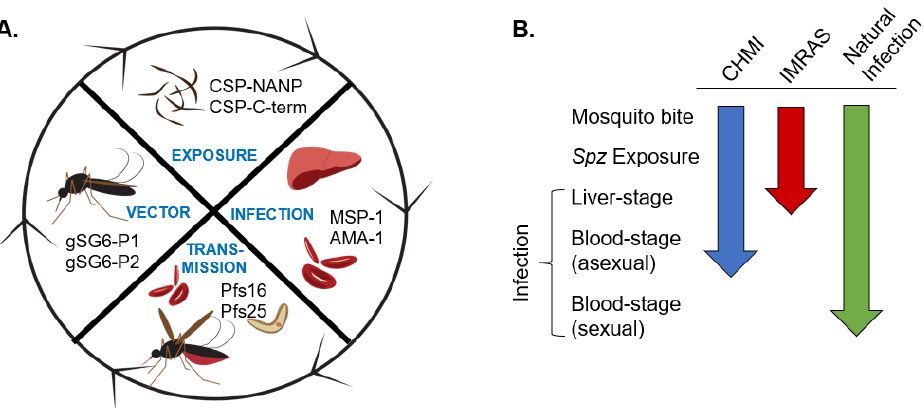
Figure 1. Antigen selection and malaria transmission cycle. ( A ) Antigens for vector, parasite exposure, infection, and transmission are shown along the malaria transmission cycle. ( B ) Different stages of exposure to the malaria transmission cycle for samples collected from individuals from CHMI, IMRAS, and natural infection in endemic areas.